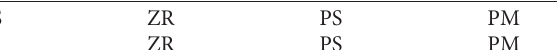
Figure 6: (a) Subordinating degree of s . (b) Subordinating degree of k Table 3: Fuzzy laws of the sliding mode control.